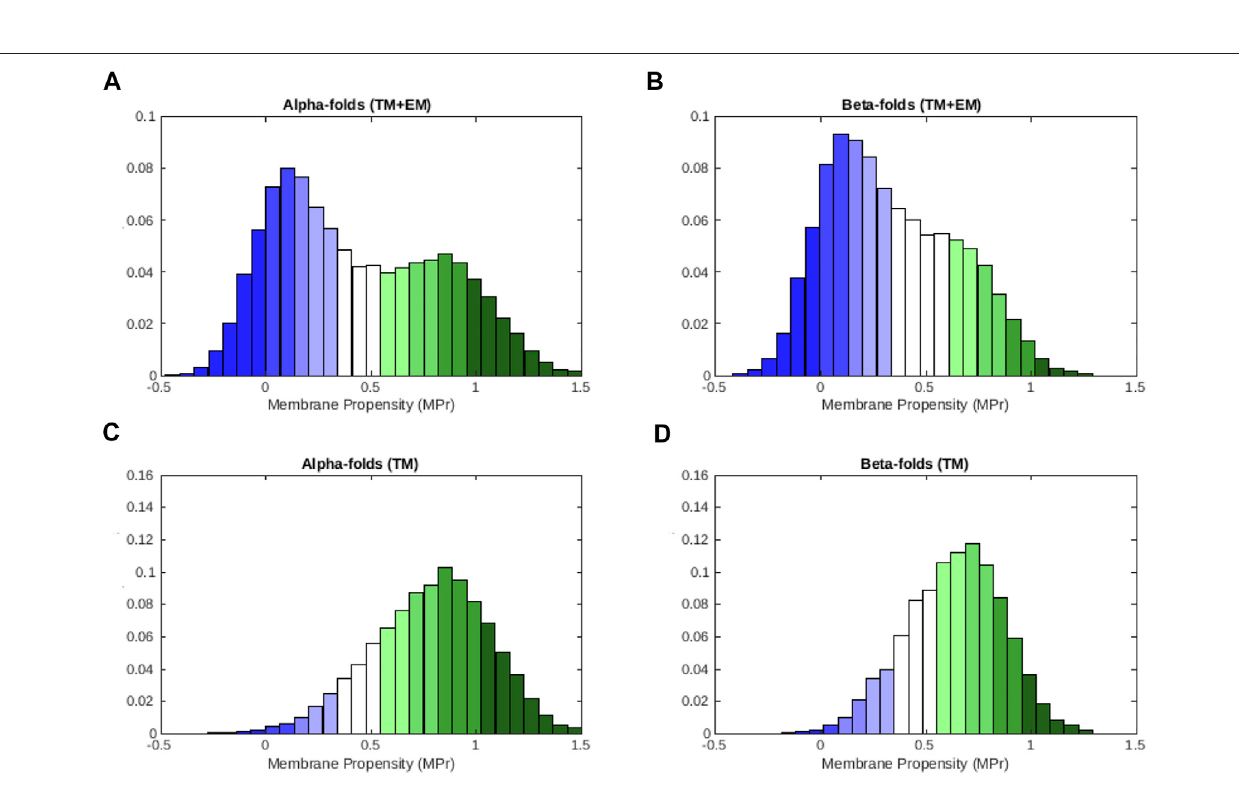
Frontiers in Bioinformatics |